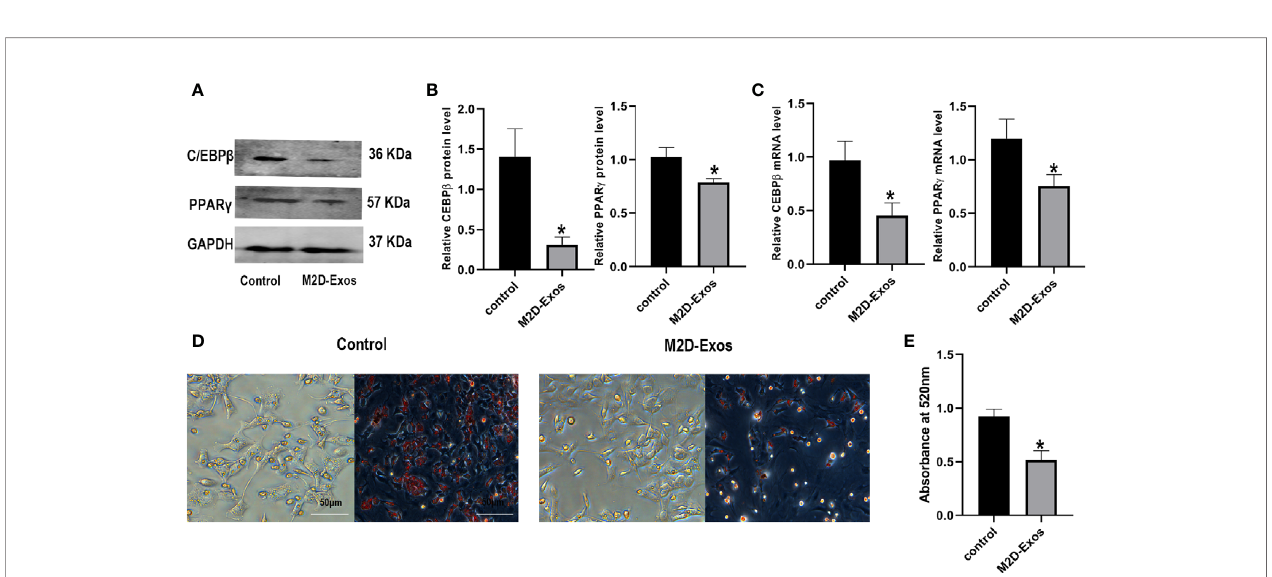
FIGURE 3 | Exosomes derived from M2 macrophages inhibited adipogenic differentiation of BMSCs. (A, B) Adipogenic proteins, C/EBP b and PPAR g , were measured by western blotting analysis and quanti fi ed. Control group was BMSCs treated in adipogenic inducer. (C) Osteogenic genes, C/EBP b and PPAR g , were measured by RT-PCR analysis. Control group was BMSCs treated in adipogenic inducer. (D) Oil red O staining was used to measure the formation of lipid droplets in BMSCs after treated by PBS (control group) or M2D-Exos for 14 days. Scale bar = 50 µm. (E) The statistical data of Oil red O staining. *p < 0.05 compared to the control group. Control group was BMSCs treated in adipogenic